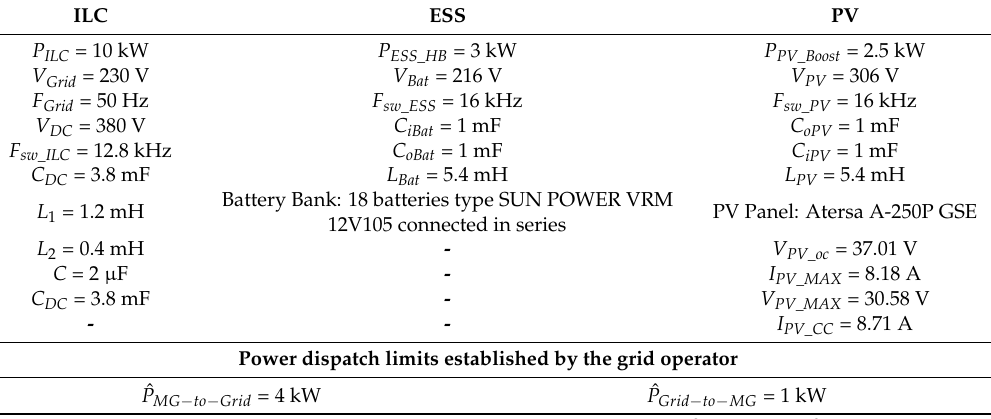
Table 3. Characteristics of the power converters composing the DC microgrid.